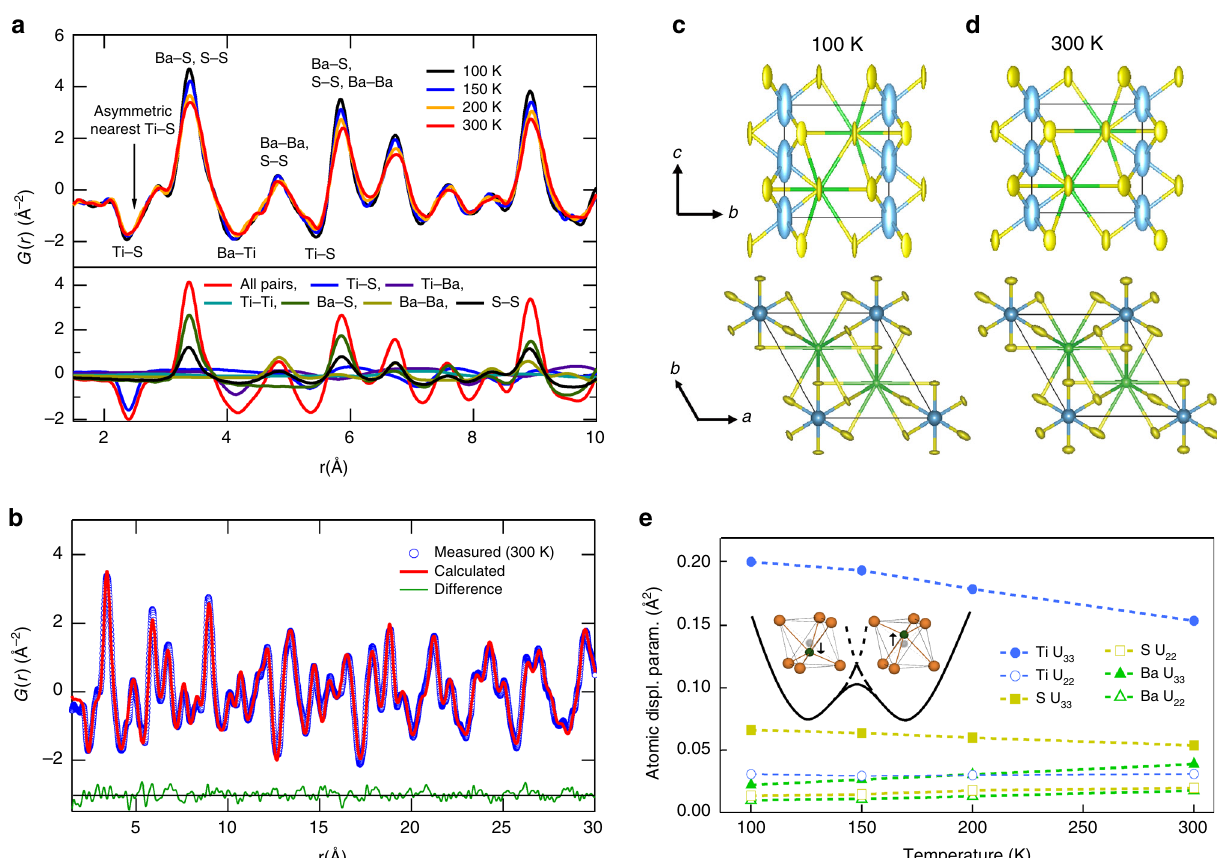
Fig. 2 Pair distribution function (PDF) measured using neutron diffraction. a Measured PDF ( G ( r )) for several temperatures (top) and a breakdown of the pair distribution function (PDF) by atomic pairs for the 100 K re fi nement (bottom). The fi rst few nearest neighbor distances are indicated. Since Ti has a negative neutron scattering length, the Ti-X peaks are negative. The nearest neighbor Ti-S peak is asymmetric and lacks temperature dependence. Note that other peaks that appear to lack temperature dependence actually consist of both positive and negative peaks as shown in the bottom panel, in contrast to the fi rst Ti-S peak. b Measured PDF (blue circles) and best fi t (red line) at 300 K. The residual difference between the measurements and fi t is also shown (green line). Anisotropic distribution ellipsoids for 90 percent probability from the fi t to PDF at c 100 K and d 300 K from different perspectives. The Ti distributions along the c axis (stretched blue ellipsoids) decrease in size with increasing temperature, the opposite of what is expected for thermal vibrations. e Derived atomic displacement parameters versus temperature. Note that the Ti-U 33 parameter decreases with increasing temperature. The inset shows a schematic for the bimodal distribution of Ti atoms residing in shallow potential